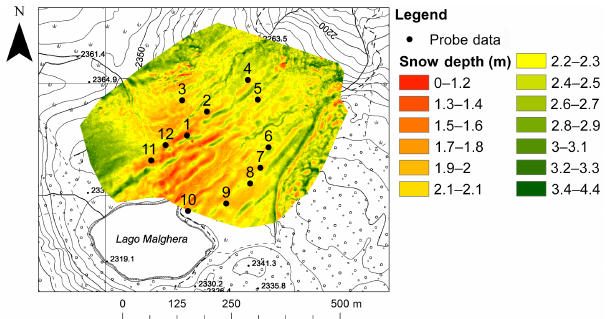
Figure 7. A map of snow depth distribution over the study area, ob- tained by means of difference of the elevations of the maps reported in Fig. 5 (5 × 5cm 2 cell size). Different colors indicate different val- ues of snow thickness (see the legend scale). Black dots indicate the location of the 12 manual measurements of snow depth (see Table 1 for IDs of the